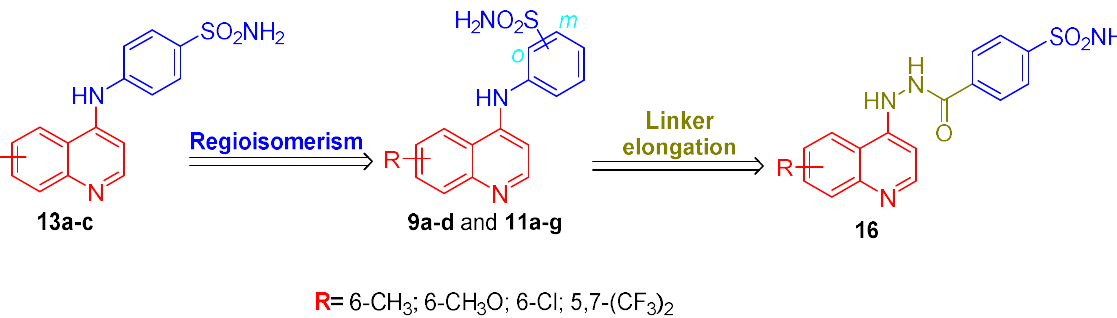
Figure 2. Design of target QBS ( 9a–d , 11a–g , 13a–c and 16